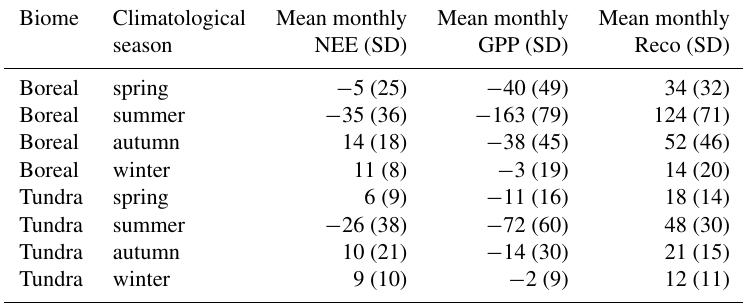
Table 4. Mean and standard deviation of monthly observations of net ecosystem exchange (NEE), gross primary productivity (GPP), and ecosystem respiration (Reco) in gCm − 2 per month. Seasons were defined based on the climatological definition (autumn: September– the atmosphere (i.e., CO 2 source), and negative numbers indicate net CO 2 uptake by the ecosystem (i.e., CO 2 sink). For consistency, GPP is presented as negative values and Reco as positive. Some sites compute only NEE and, consequently, NEE summaries might not entirely match with GPP and Reco